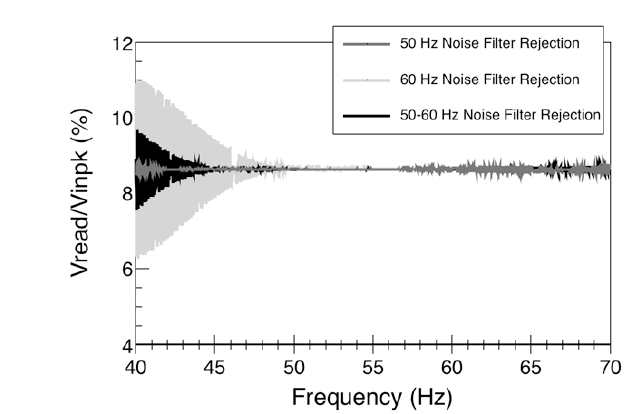
Figure 5. Residual fraction of the input signal as a function of the signal